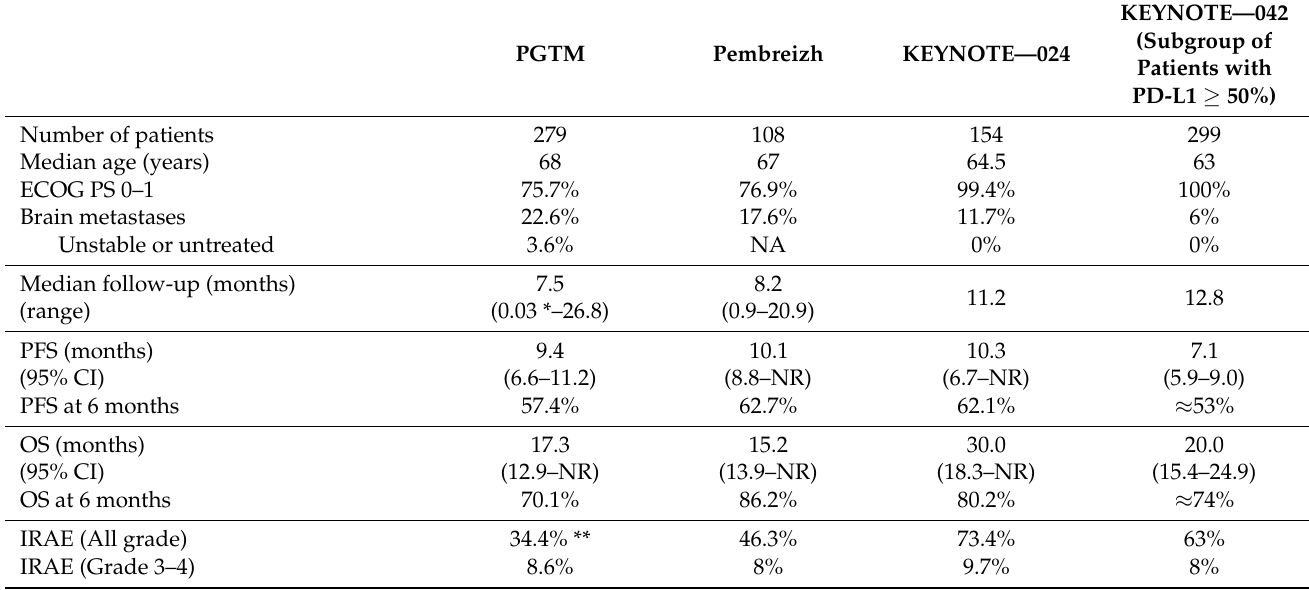
Table 5. Comparison of PFS, OS, and IRAE of PGTM population with those of other studies on pembrolizumab as a first-line treatment of NSCLC in patients with a PD-L1 ≥